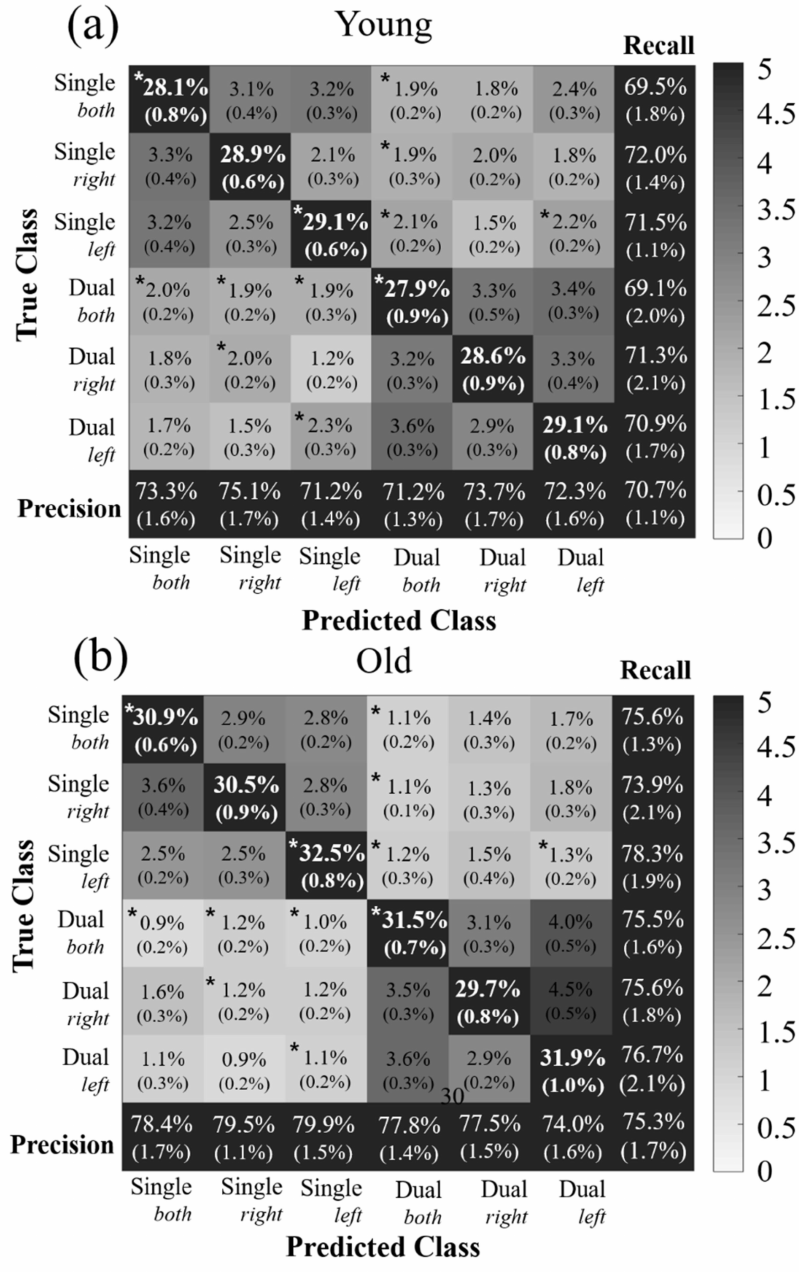
Figure 4. Confusion matrix of the six-class classification results using CNN in ( a ) the younger and ( b ) older groups. Each row and column presents the true and predicted class, respectively. The values inside the cells represent the mean and standard error of the intrasubject scores of classification in the corresponding group in the form of Mean (SE). The right-most column and bottom row represent the recall and precision of the classification results. The overall accuracy of each group is presented at the bottom-right corner. The asterisks show the significant difference calculated by the two-sample t -test in the classification results between the younger and older groups (two-sample t -test, p < 0.05), except for the recall and precision lines. The colors of each cell visualize the mean value (%) written inside the cells. Since the maximum value of the off-diagonal values is 5%, the range of the color bar is from 0 to 5 (%). The colors of the cells visualize their off-diagonal values. The asterisks represent the scores, which show the significant difference calculated by the two-sample t -test between age groups in a six-by-six confusion matrix (two-sample t -test, p <